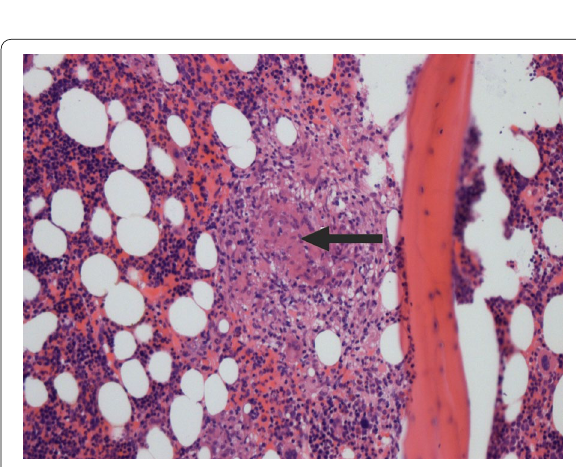
Fig. 2 Histological image (10 biopsy showing caseating epithelial granulomas scattered within slightly hyperplastic bone marrow (granuloma highlighted by black